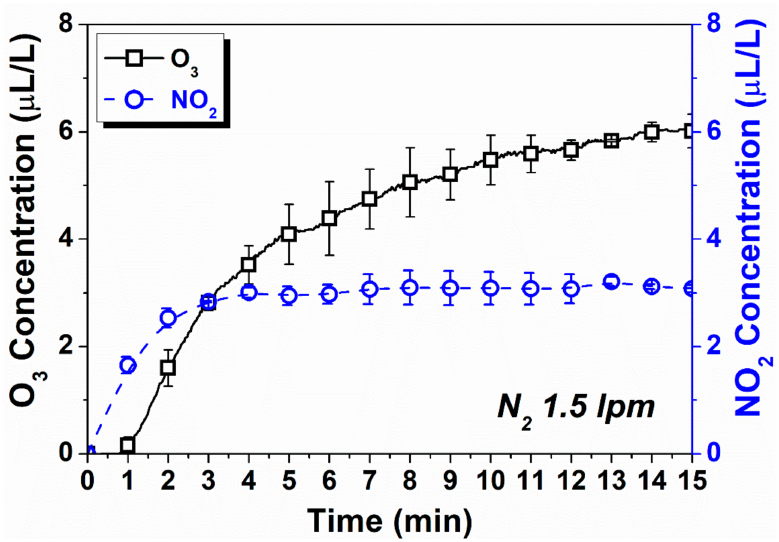
Figure 3. Measured O 3 and NO 2 concentrations according to the time variant. Changes in O 3 (black line) and NO 2 (blue line) concentrations during plasma discharge 15